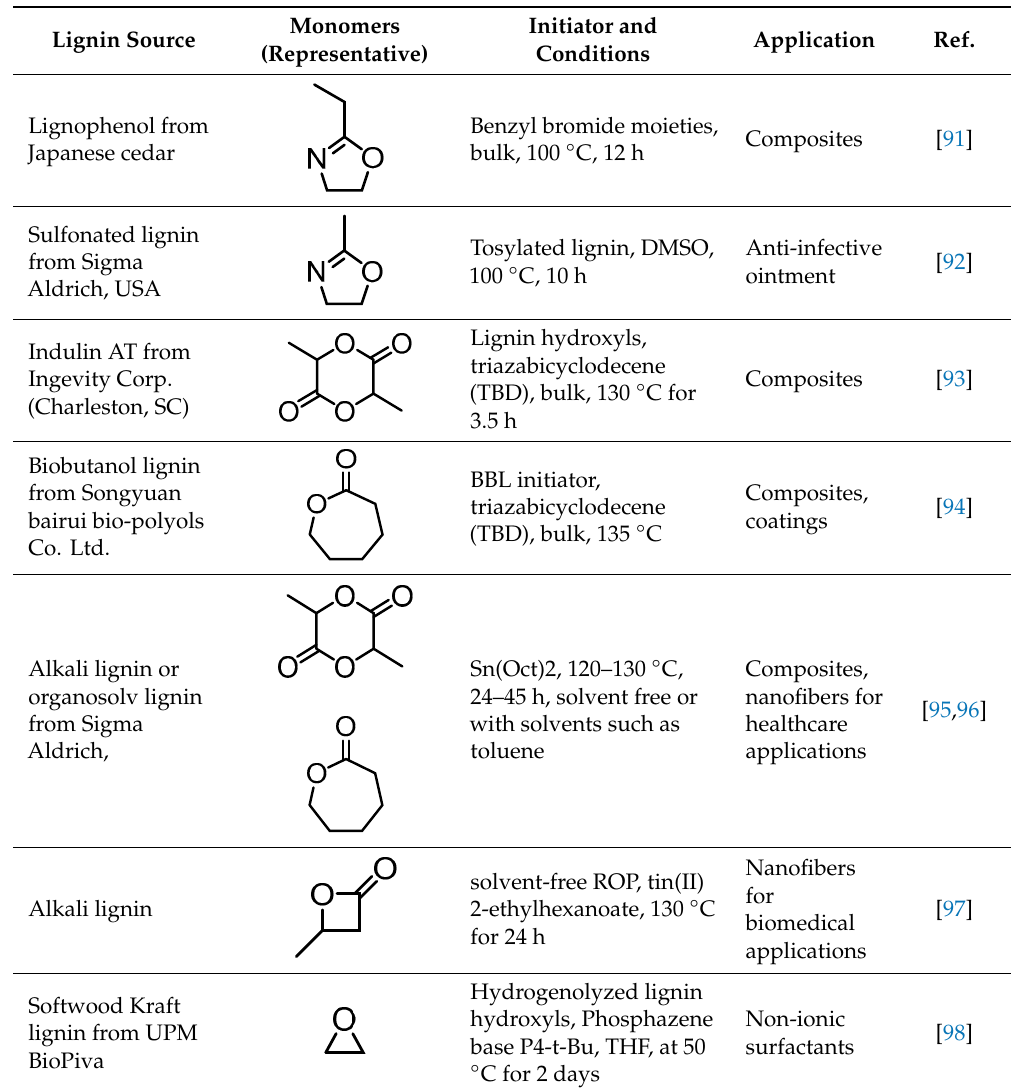
Table 4. ROP literature for the preparation of lignin